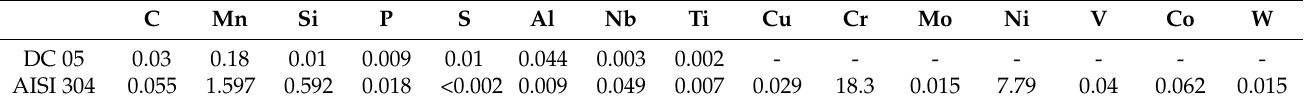
Table 3. Chemical composition of steels (in weight % ).